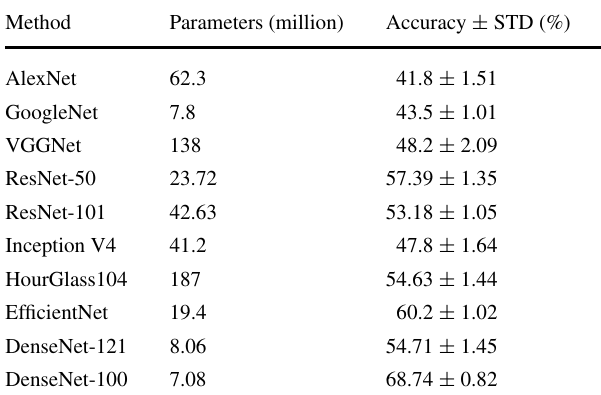
Table 5 Performance comparison of the proposed approach with other feature extraction models Method